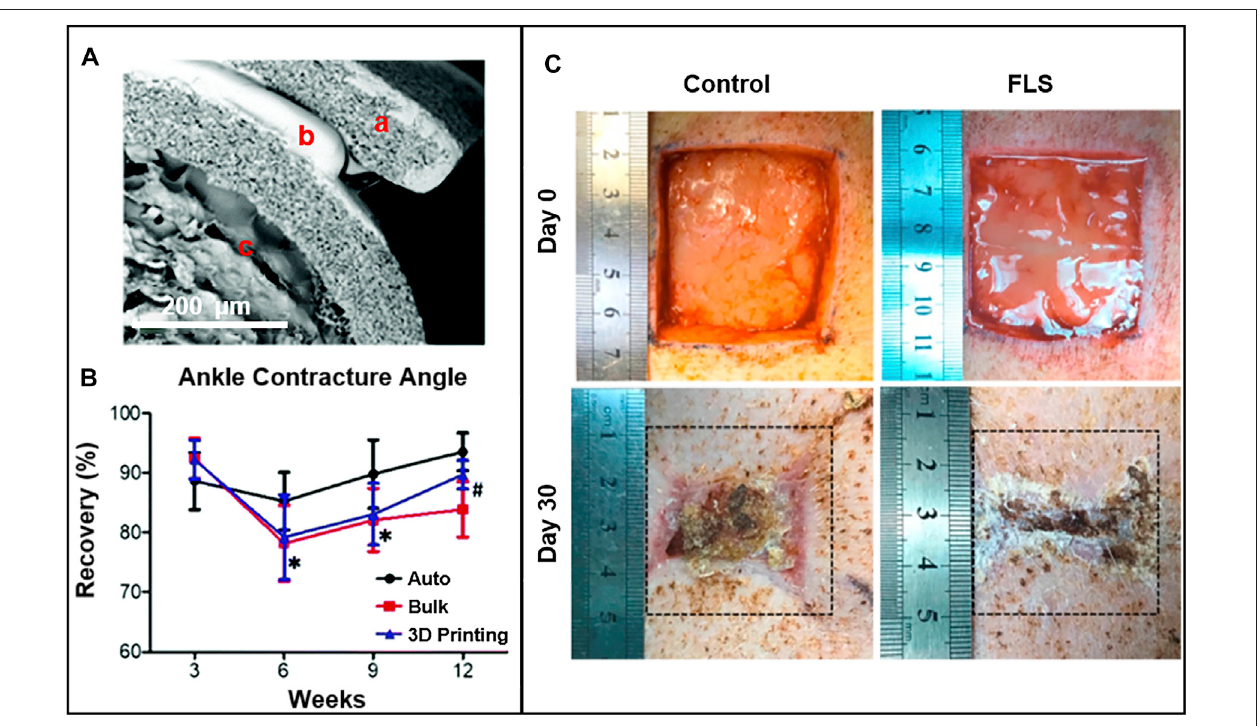
FIGURE3|(A) TheSEMof3Dprintingnerveguidanceconduitafterfreeze-drying.Reproducedwithpermission(Yooetal.,2020).Copyright2020,RoyalSocietyof Chemistry. (B) Results of ankle contracture angle of autograft, bulk and 3D printing groups measured at 3, 6, 9, and 12 weeks following nerve reconstruction. * p <